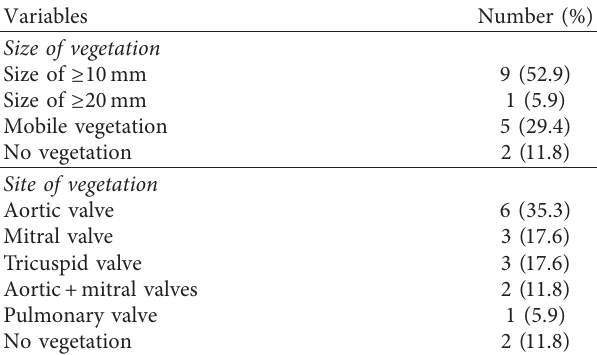
Table 2: Size and site of vegetation detected by echocardiography in IE patients ( n � 17).